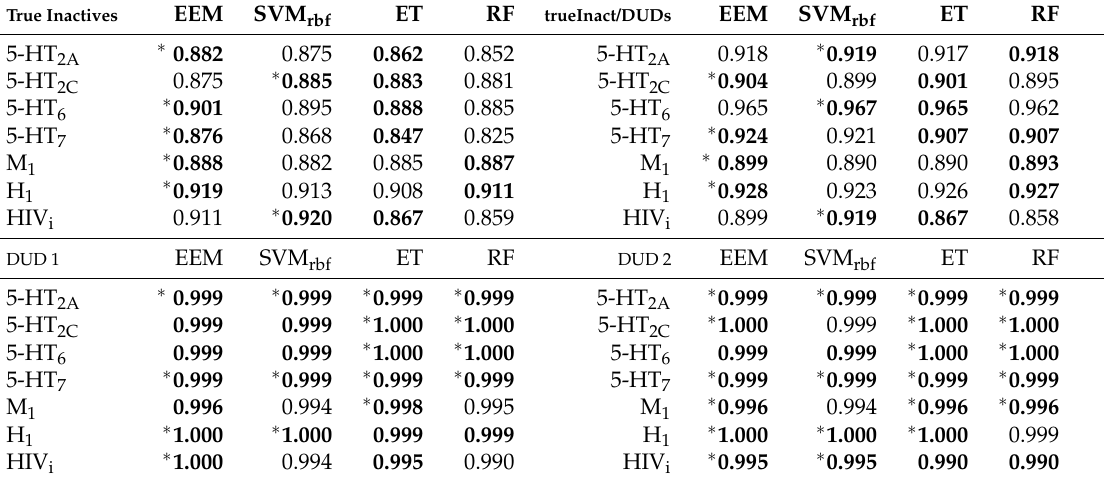
Table 5. Comparison of the BAC scores obtained for each experiment, in which the method chooses the best fingerprint. Asterisk indicates the highest BAC values obtained for a particular